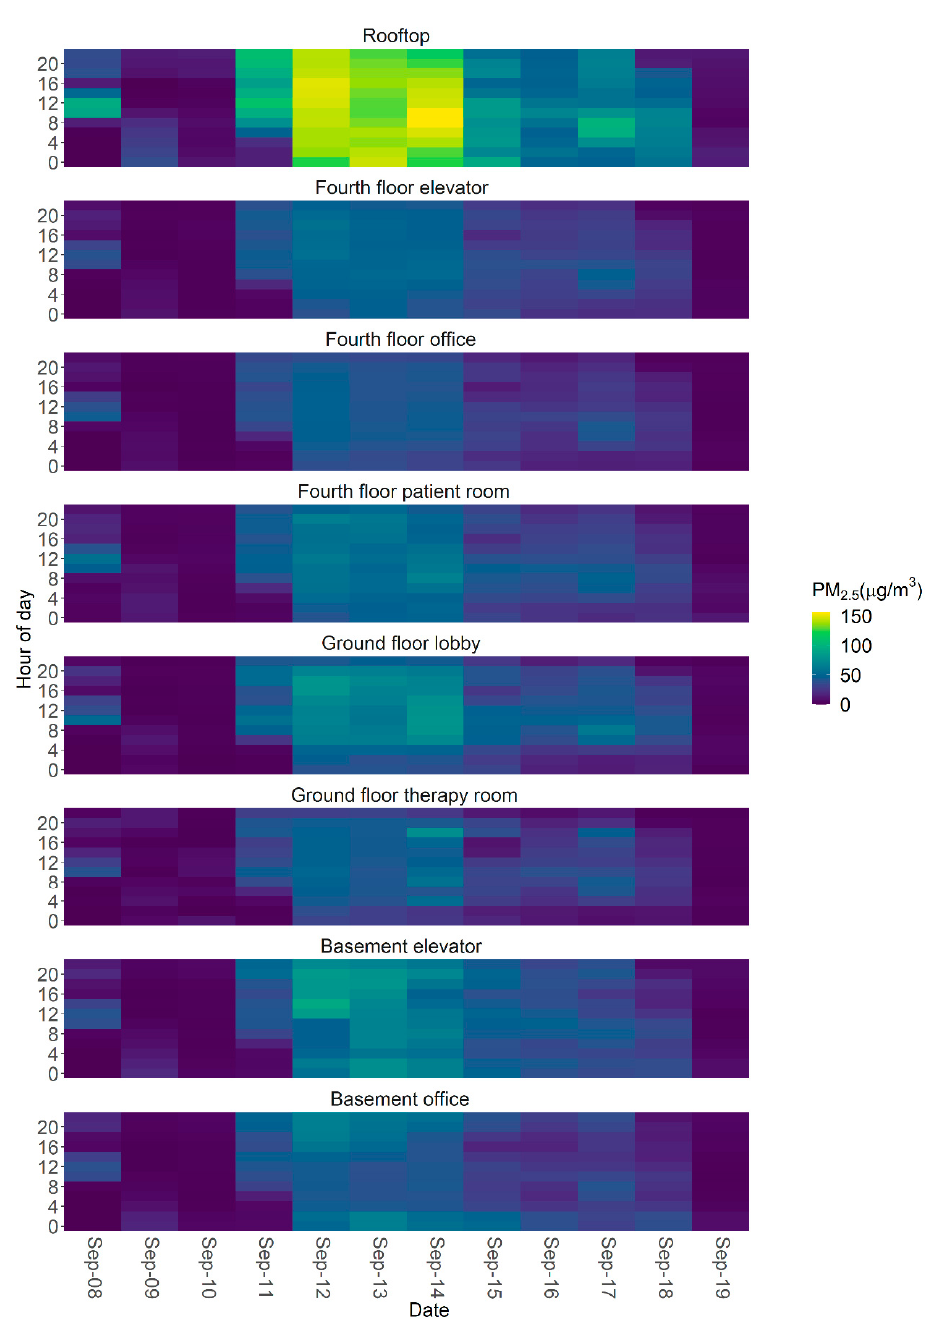
Figure 5. Heat maps of 2-h averaged PM 2.5 concentrations at the rehabilitation facility during the wildfire smoke episode. The low cost sensor on the rooftop is shown at the top, and those located indoors are shown below. The y-axis of each plot indicates the time of day. Indoor peaks have not been removed from these data. Data from the morning of September 11 show that smoke moved rapidly indoors as the rooftop concentration started to increase, and overnight data from September 18–19 show that smoke cleared rapidly out of the building as rooftop concentration decreased.